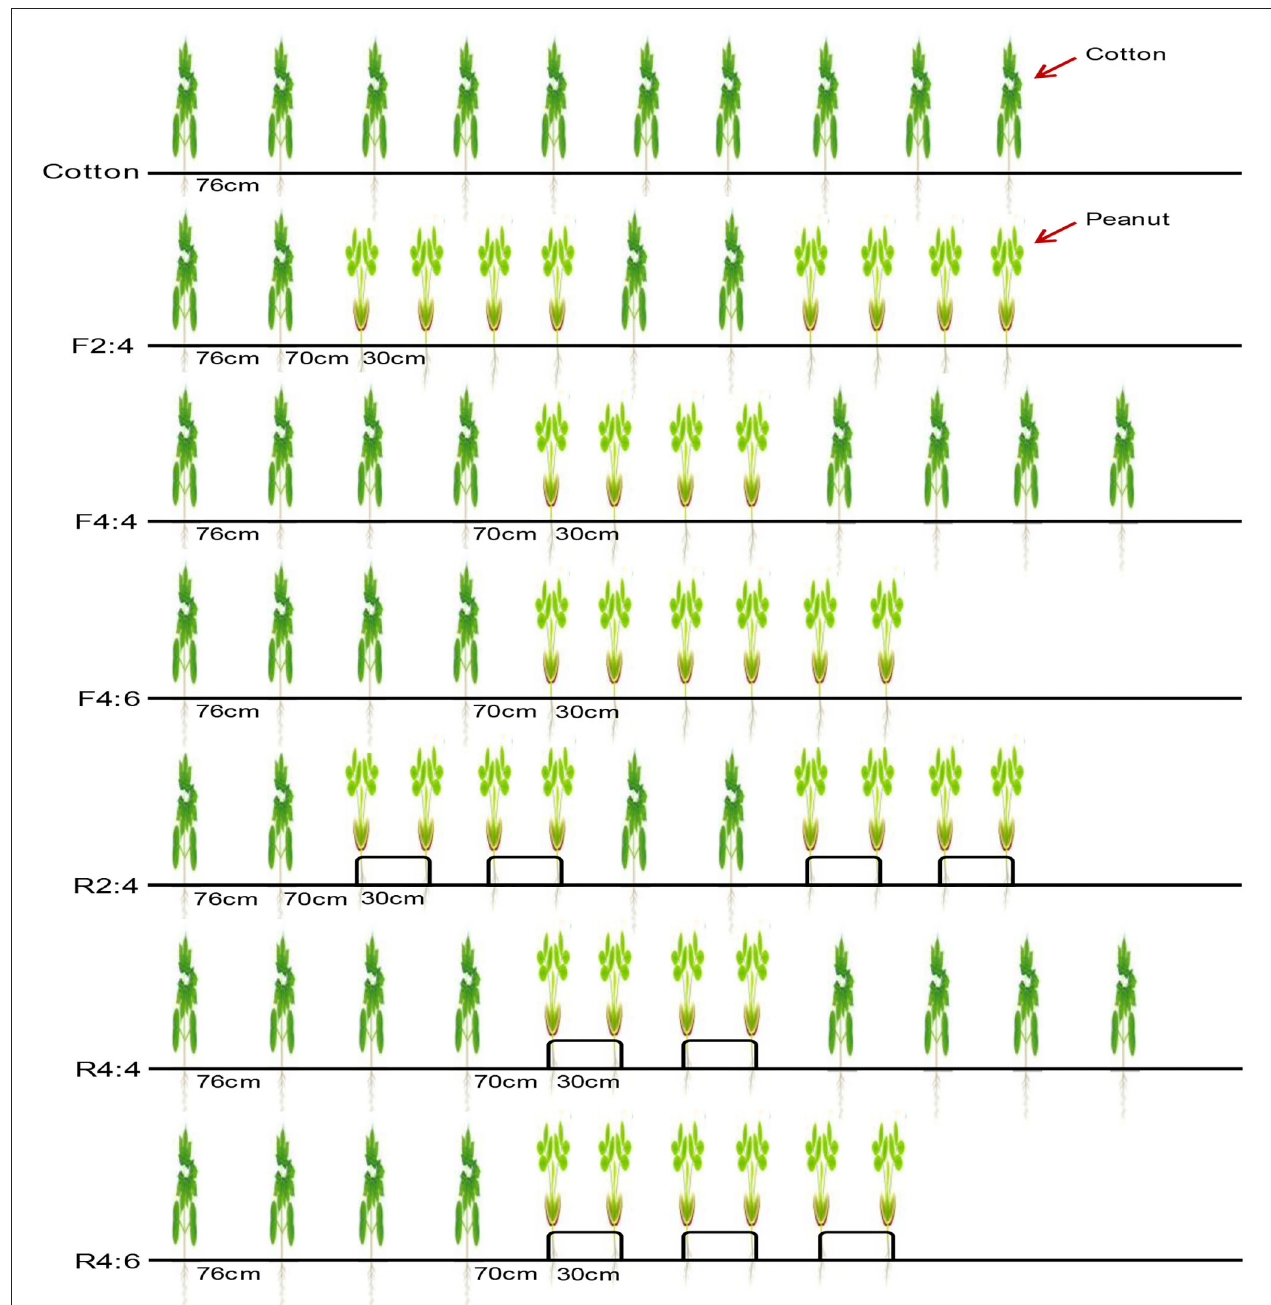
FIGURE 2 | Sketch of field experiments in cropping patterns.